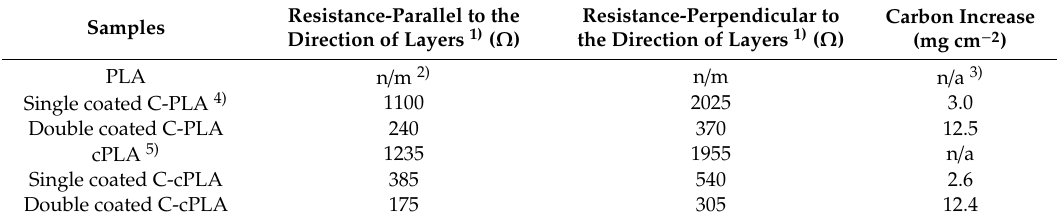
Table 1. The measured resistance and carbon loading increase of carbon-coated samples.